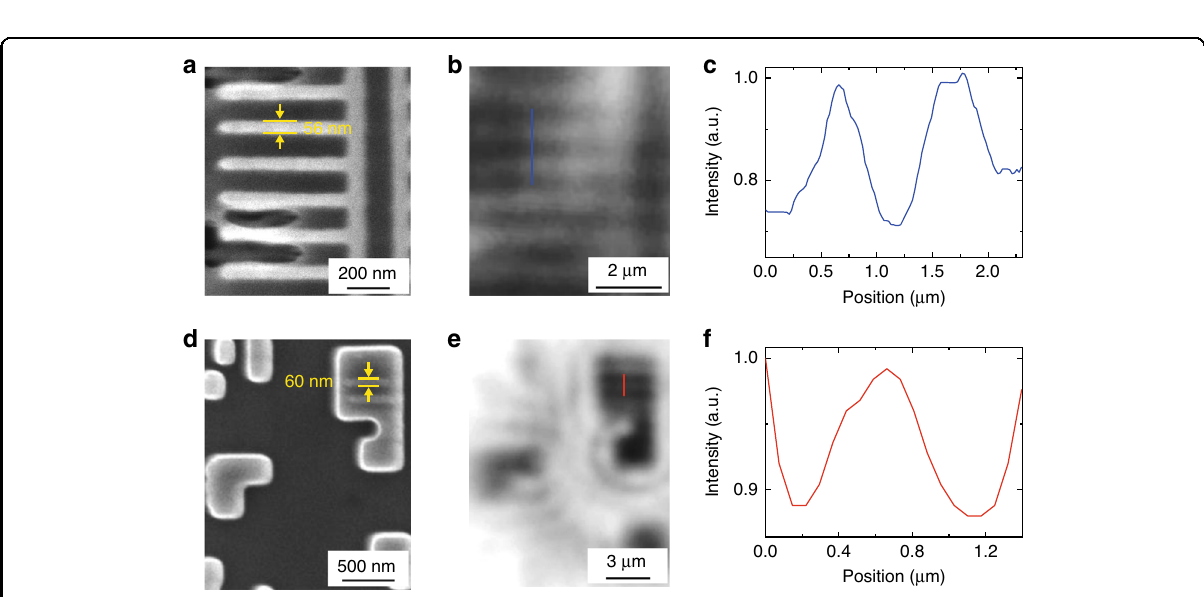
Fig. 7 Semiconductor applications of the HHMS. Metal wires and functional devices in a commercial CPU chip are imaged by ( a ) and ( d ) SEM, and ( b ) and ( e ) HHMS. c , f Intensity pro fi les along the blue and red lines in ( b ) and ( e